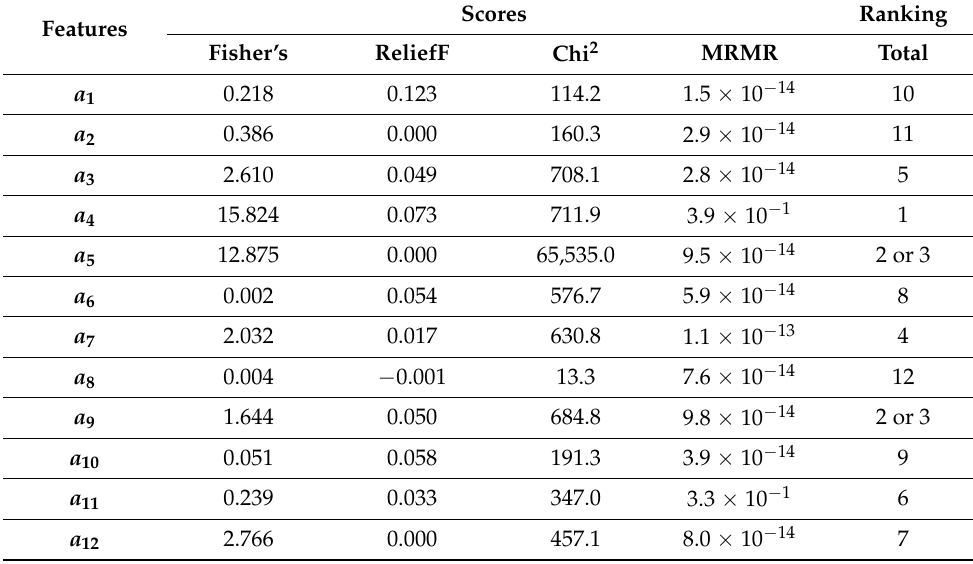
Table 3. Results of applying filters for the features of the balloon signals. Features